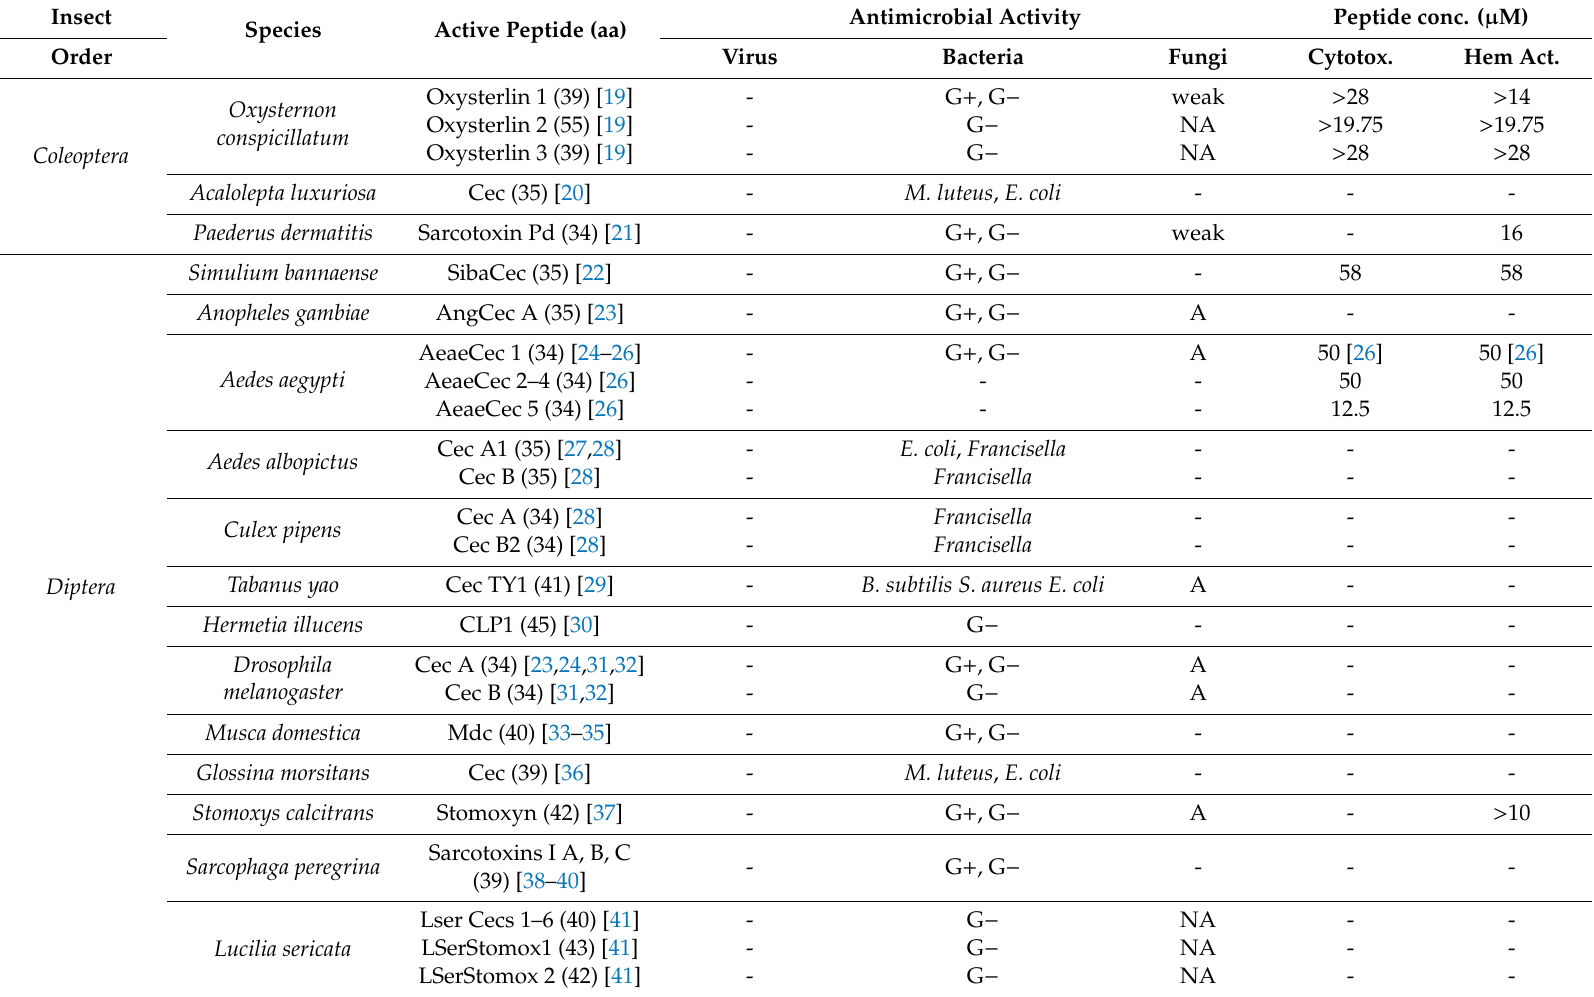
Table 1. In vitro antimicrobial activity and toxicity against mammalian cells of natural Cecropins (Cecs) and Cec-like peptides.